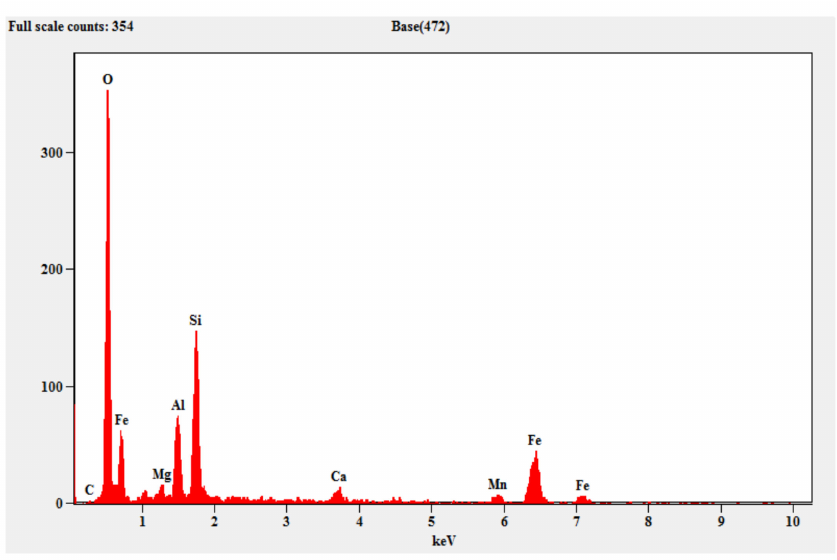
Figure 13. EDAX for fly ash.